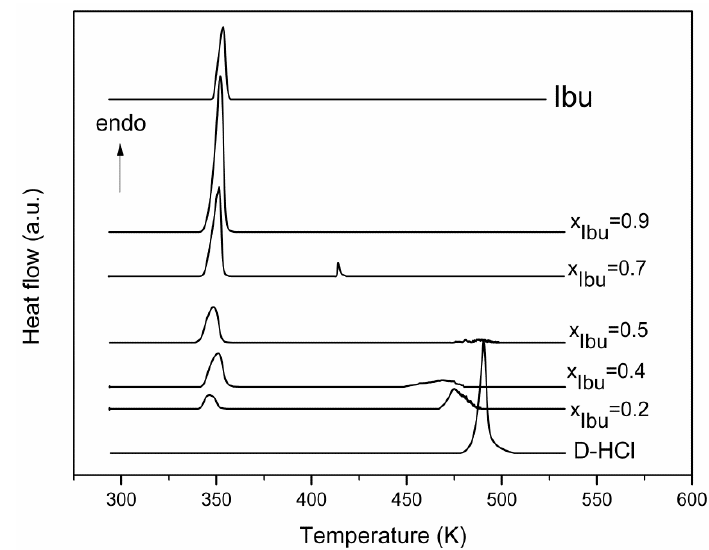
Figure 3. DSC curves for Ibu and D-HCl and their binary mixtures.